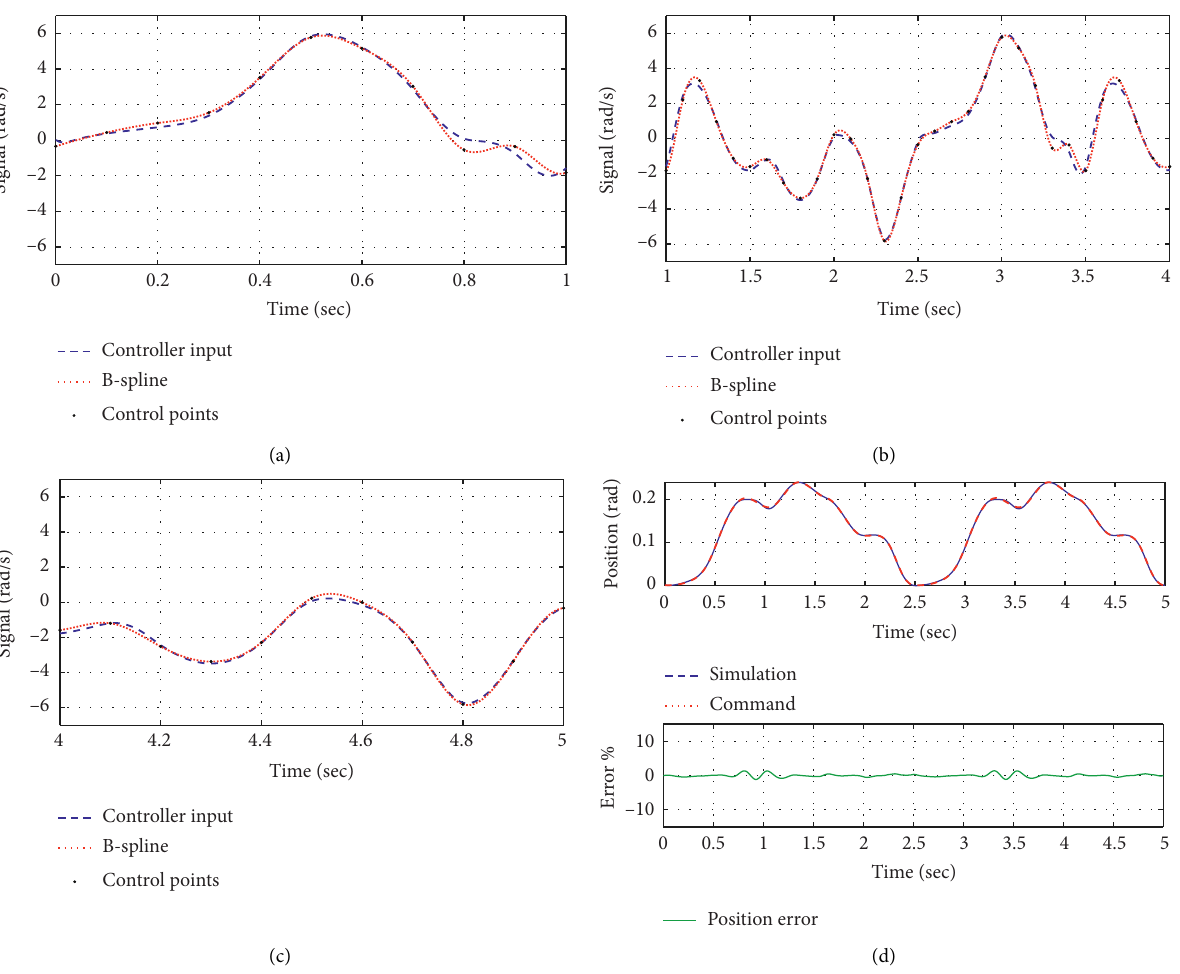
Figure 6: Input modification scheme of manipulator controller based on improved B-spline optimization. (a) Controller input and compensator output in part 1. (b) Controller input and compensator output in part 2. (c) Controller input and compensator output in part 3. (d) Comparison and error of reference position and measurement position.